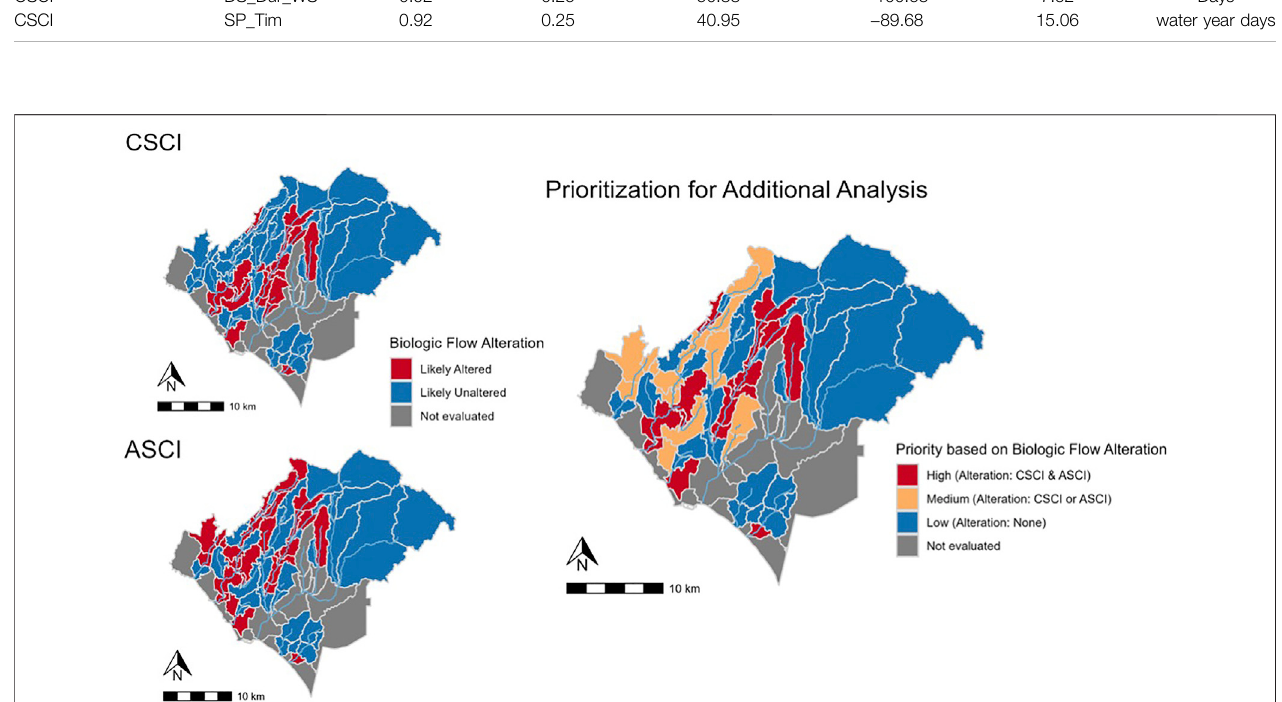
FIGURE8| Locationsofbiological alteration for CSCI and ASCI individually (left panel) and fi nal prioritization using synthesized alteration from both bioassessment indices (right panel).